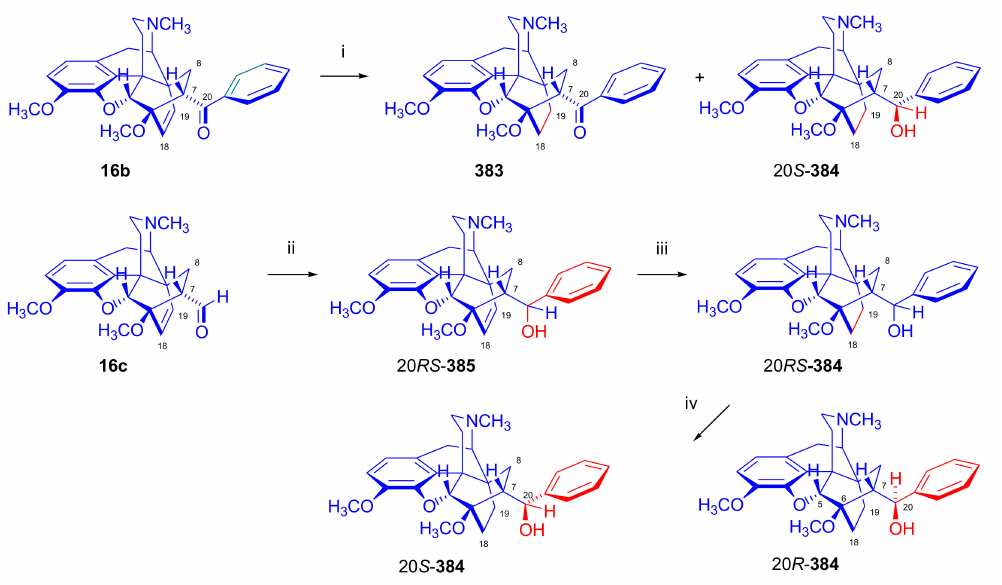
Figure 97. Catalytic hydrogenation of nepenthone under different conditions and synthesis of 20 R - dihydronepenthol. Reagents and conditions : (i): H 2 , EtOH, catalyst (Pd-C, Pd-C + PtCl 4 , Pt-C or Rh-C), p (4–6 bar), t (25–64 ◦ C), (ii): PhMgBr, toluene-diethyl ether; (iii): H 2 , EtOH, 3 bar, 55 ◦ C; and (iv): fractional